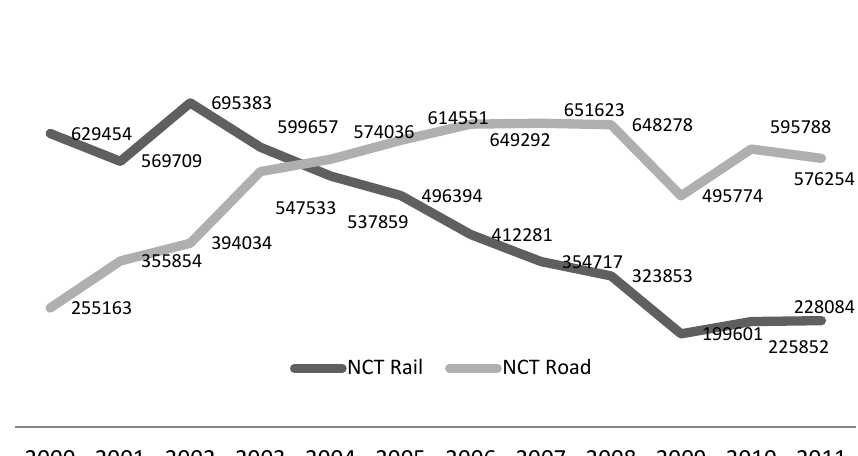
FIGURE 2: Timber transported on rail and road, annual tonnage, 2000 to 2011 Source: NCT Forestry Co-operative Limited